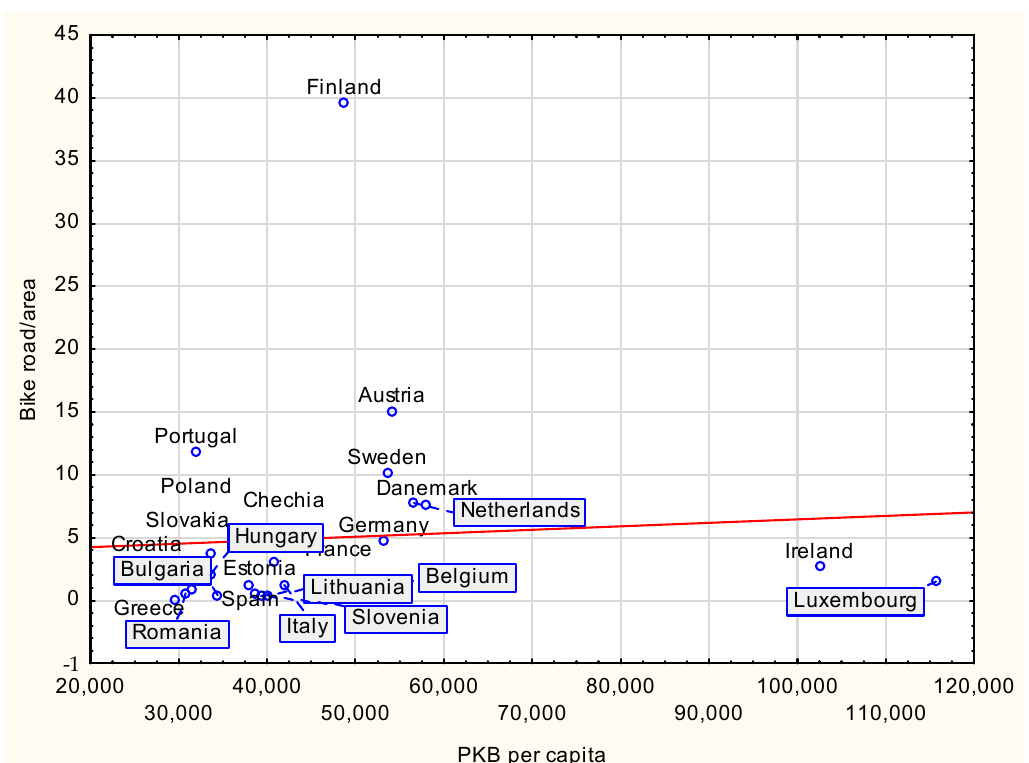
Figure 9. Scatter plot between GDP per capita and the average length of bikeways per square kilometer of area in smart cities. Source: author’s